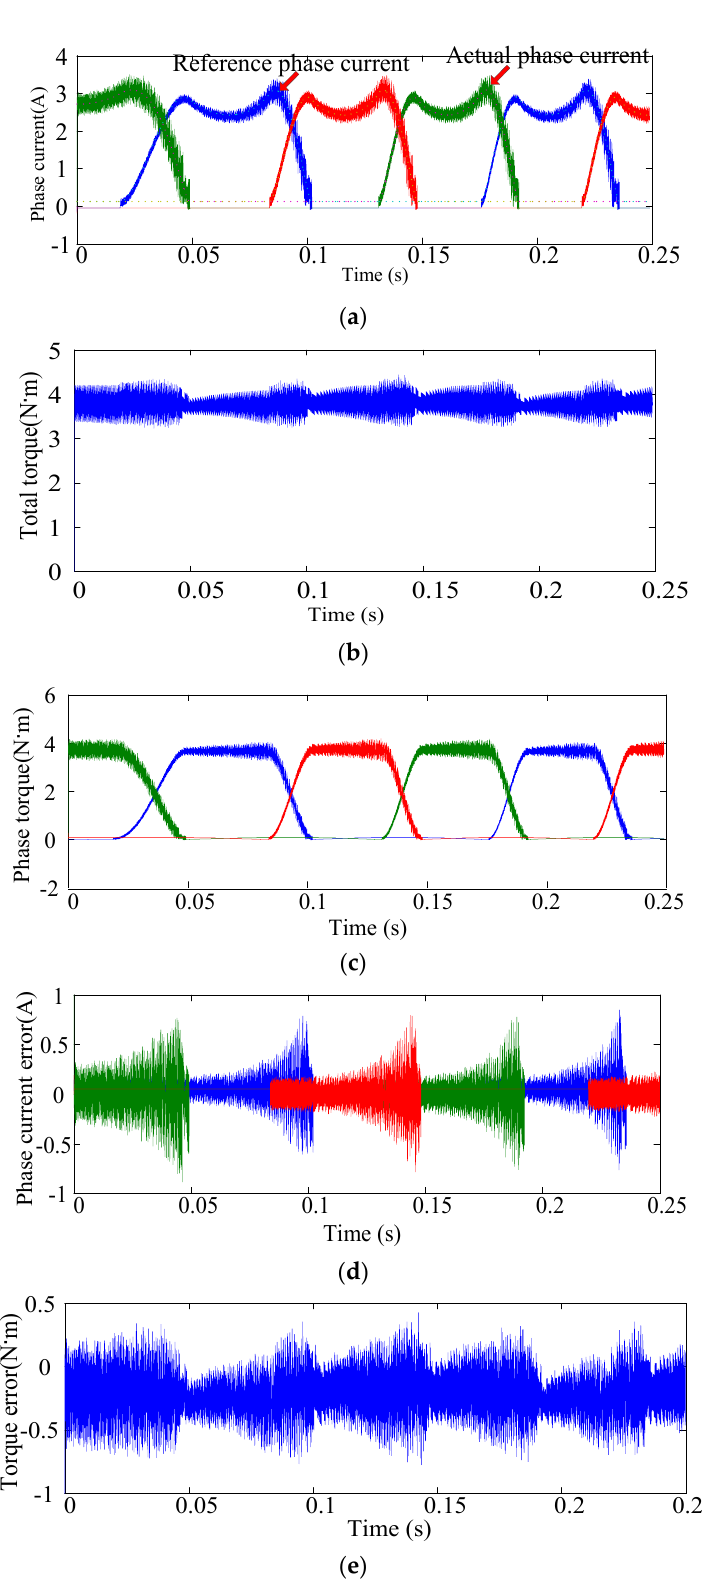
Figure 9. Simulation results when using current chopping control (CCC) method based on cube TSF (band is set 0.1, reference torque is set 3.7 N · m and sample time is set 1 × 10 − 5 s). ( a ) Profiles of phase current and its reference ( b ) Total torque ( c ) Phase torque ( d ) Phase current error ( e ) Torque error.